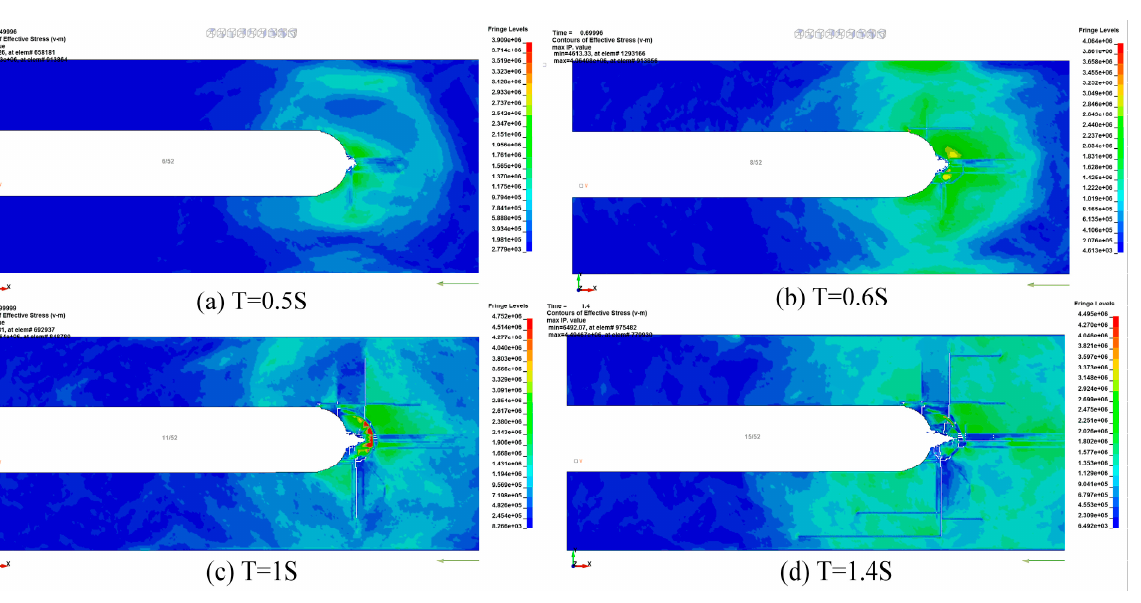
Figure 11. Breaking mode of level ice (www.eworldship.com, accessed on 19 July 2014).